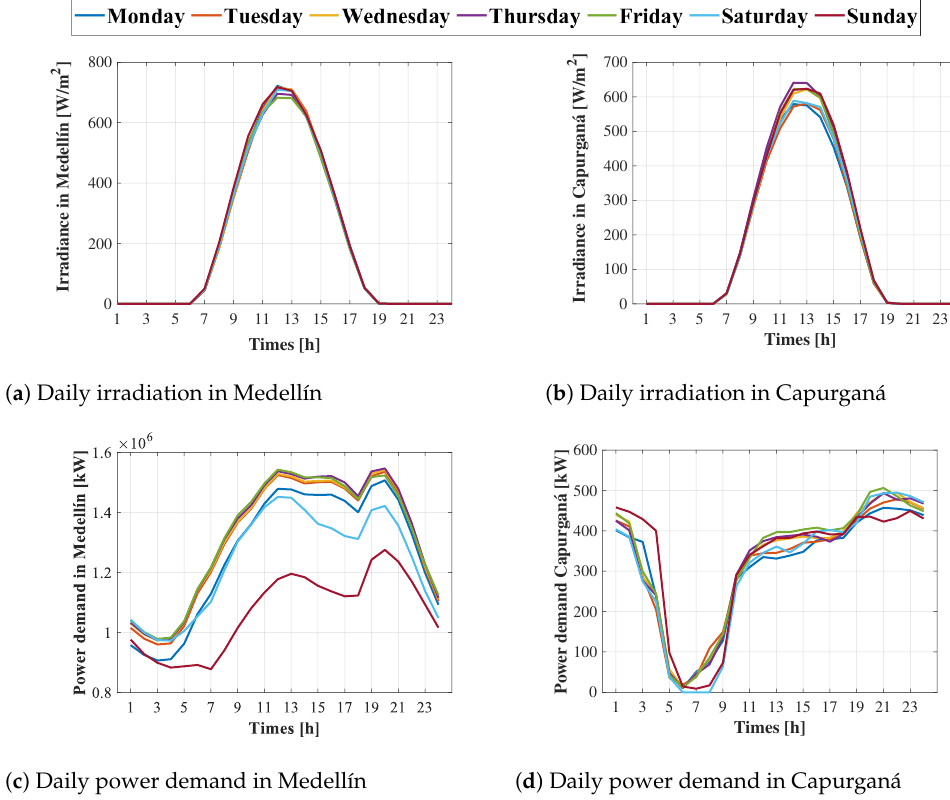
Figure 7. Variable solar irradiation and demand in an urban and rural area in